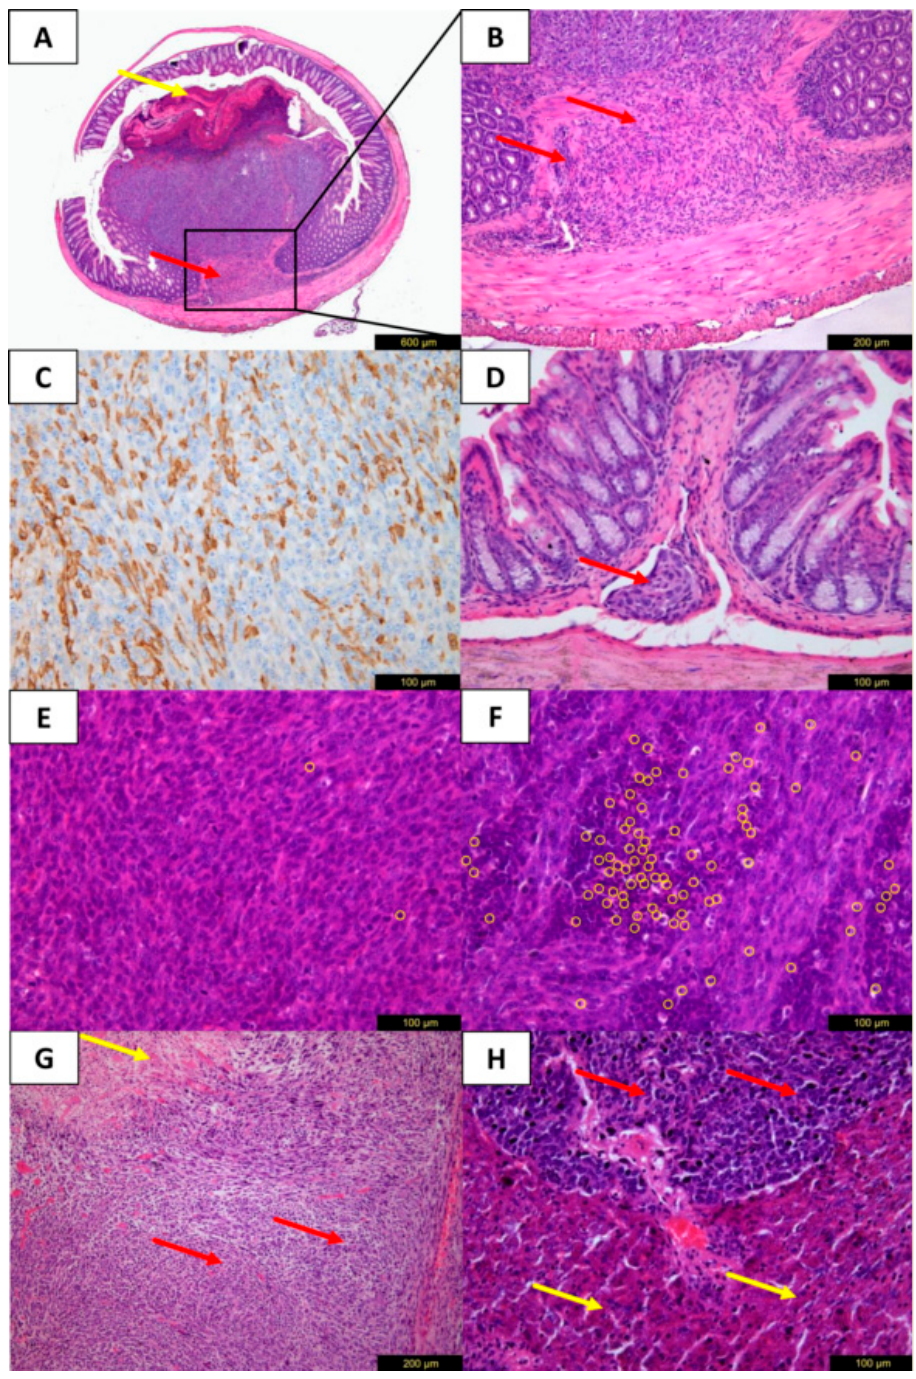
Figure 5. Microscopic tumor evaluation of the CT26/BALB/C model with H&E ( A , B , D – H ) and immuno-histochemical staining for CK20 ( C ). Transverse section of the colon near the injection site with growth of the primary tumor. The malignant tumor with moderate atypia of the nuclei shows luminal ulceration ( A , yellow arrow) and infiltration of the muscularis propria layer ( A , B , red arrows) corresponding to a pT2 category in humans. ( C ) Cytoplasmic positivity of tumor cells for CK20. ( D ) Lympho-vascular invasion (red arrow) corresponding to an L1 category in humans near primary tumor site. ( E , F ) Scoring of stromal tumor-infiltrating lymphocytes (yellow circles) with a score of 1 (0–10% stromal TILs, E ) and a score of 6 ( > 50% stromal TILs, F ). ( G ) Mesenteric lymph node metastasis with tumor infiltrates (red arrows) and necrosis (yellow arrows). ( H ) Liver metastasis with tumor infiltrates (red arrows), normal liver tissue (yellow